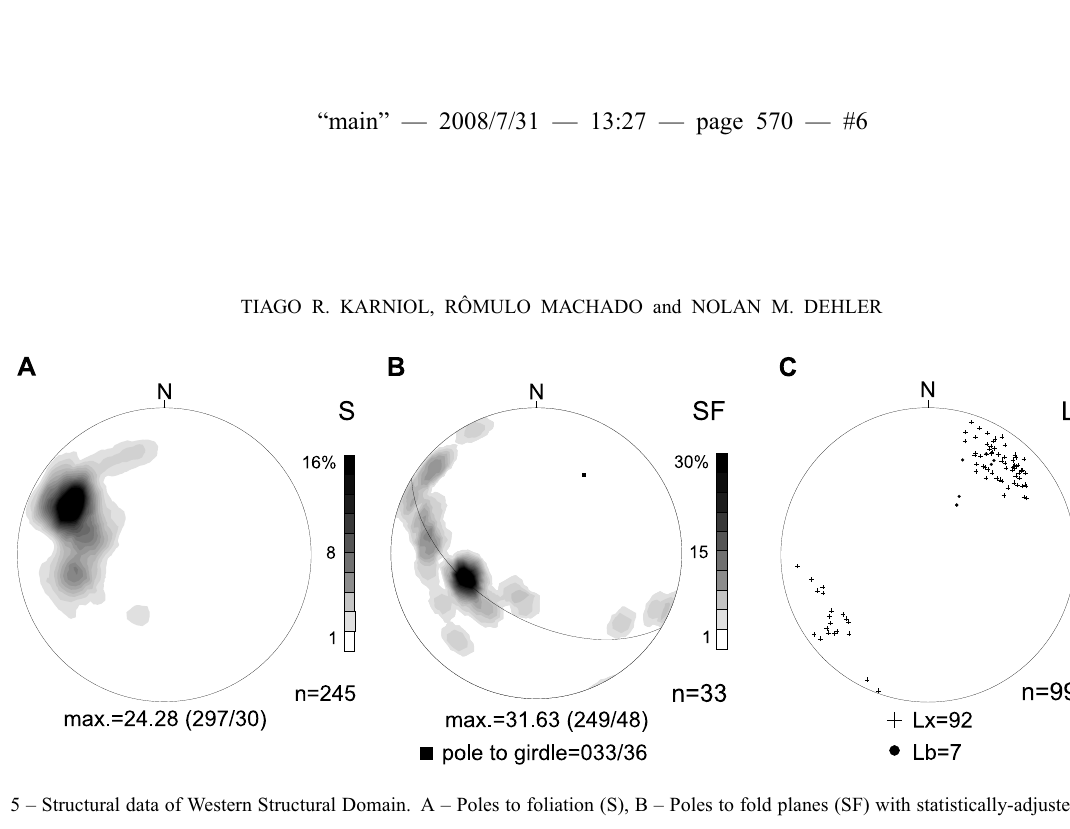
Fig. 5 – Structural data of Western Structural Domain. A – Poles to foliation (S), B – Poles to fold planes (SF) with statistically-adjusted axis, C – Linear data (L): Lx – mineral and stretching lineation, Lb – fold axis. Equal area lower hemisphere Schmidt-Lambert stereographic projection. Number of data (n)